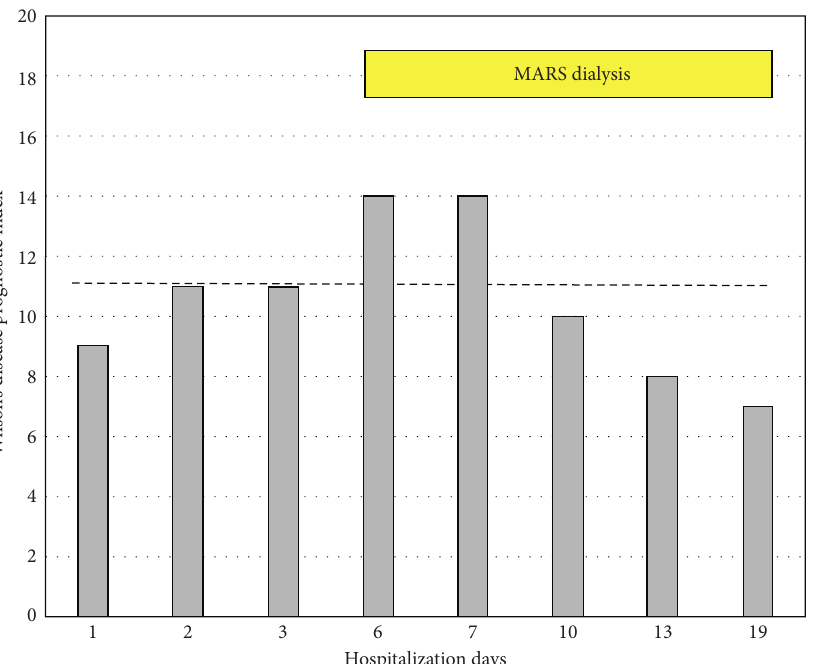
Figure 4: Evolution of Wilson’s disease prognostic index during hospitalization. A score ≥ 11 (dashed line) is associated with a high probability of death without LT according to